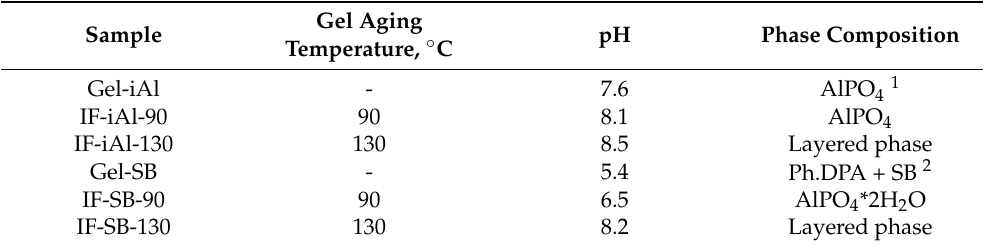
Figure 1. X-ray diffraction patterns of initial gels and intermediate phases: ( a ) Gel-iAl sample; ( b ) Sample IF-iAl-90; ( c ) Sample IF-iAl-130; ( d ) Gel-SB sample; ( e ) Sample IF-SB-90; ( f ) Sample IF-SB- 130. Table 2. Chemical and phase composition of initial gels and intermediate phases. Phase composition and pH of initial gels, intermediate phases of crystallization products.